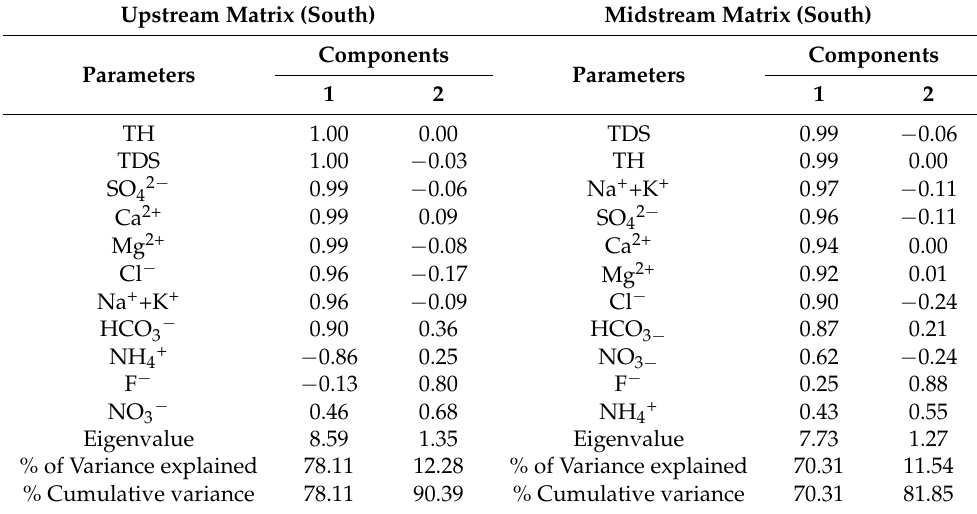
Table 5. Load matrix of the main components.